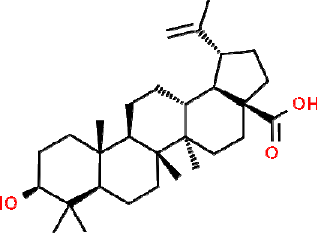
Figure 1. Chemical structure of betulinic acid. This structure was obtained from Chemspider (http://www.chemspider.com; ChemSpider ID58496).